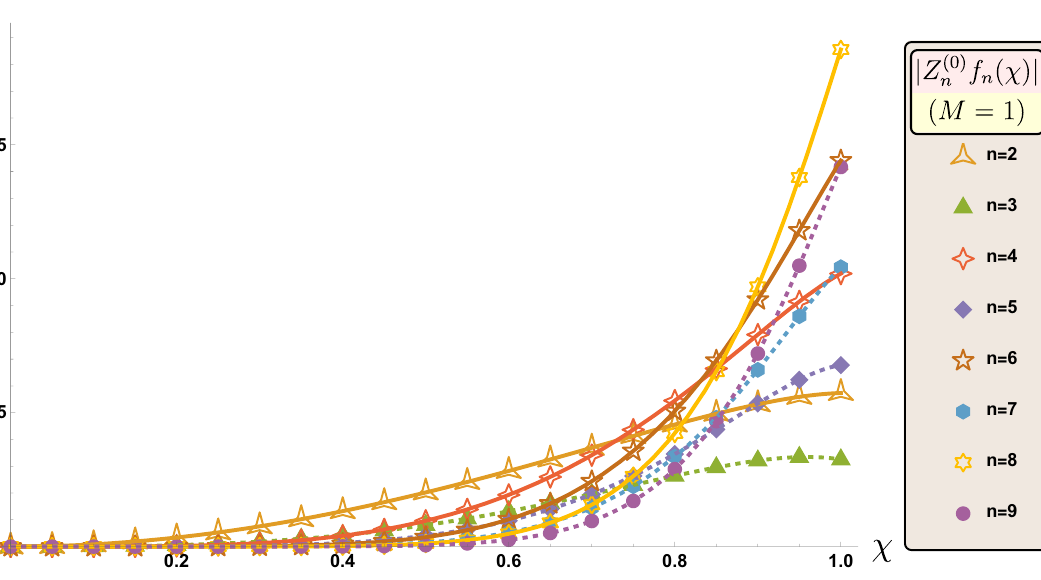
Figure 2 . Absolute correction, | Z (0) n f n ( χ ) | , to the Kerr multipoles for six-derivative theories. Only the first 8 non-trivial terms are shown for